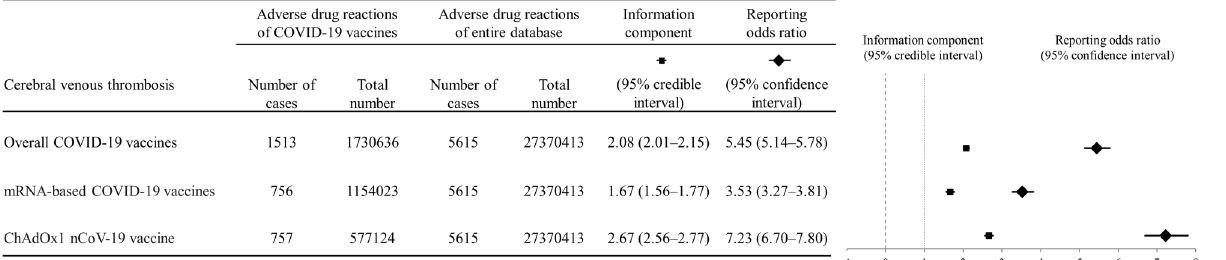
Figure 2. Disproportionality analysis between mRNA-based vaccines and the ChAdOx1 nCoV-19 vaccine to compare cerebral venous thrombosis occurrence in vaccinated individuals with the entire VigiBase database. The information component (IC) and reporting odds ratio (ROR) were calculated for the disproportionality analysis. In this forest plot, overall COVID-19 vaccines showed significantly positive associations with cerebral venous thrombosis by IC 025 (2.01) and ROR 025 (5.14).